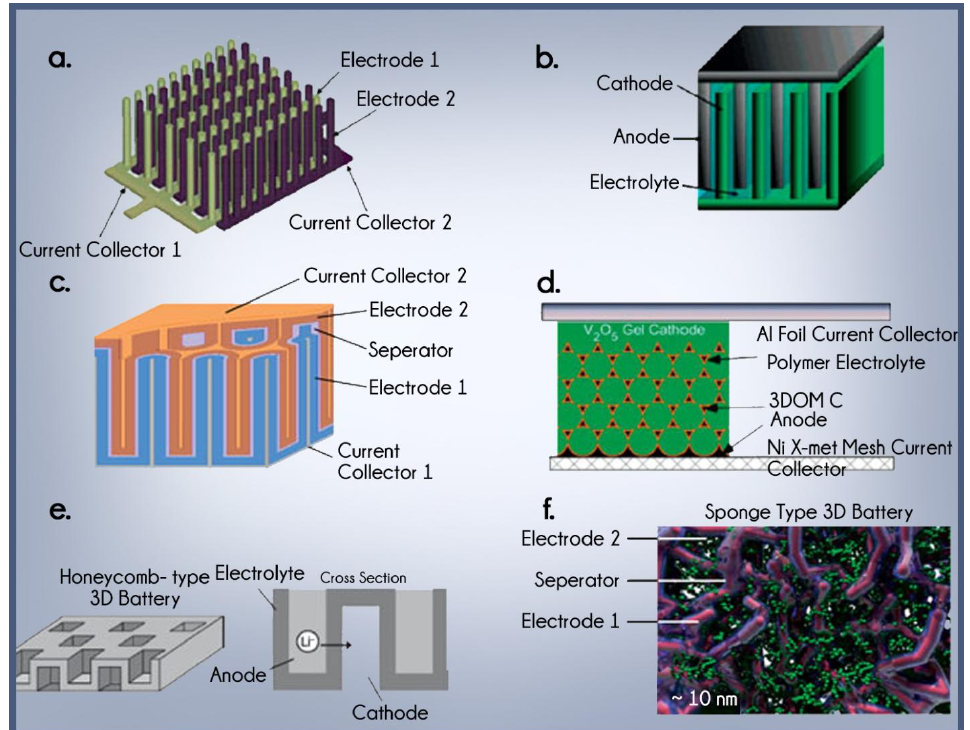
Figure 5. Schematic of 3D electrode architectures for 3D battery designs are shown. Adapted from reference 26. ( a ) interdigitated rod electrodes (©2007, IEEE) [24]; ( b ) interdigitated plate electrodes (©2004, American Chemical Society) [25]; ( c ) concentric tube design; ( d ) inverse opal structure based on the 3D ordered macroporous carbon (3DOM-C) structure (©2007, Electrochemical Society) [26]; ( e ) honeycomb-structured electrolyte (©2011, Elsevier) [27]; ( f ) aperiodic ―sponge‖ design (©2007, American Chemical Society)